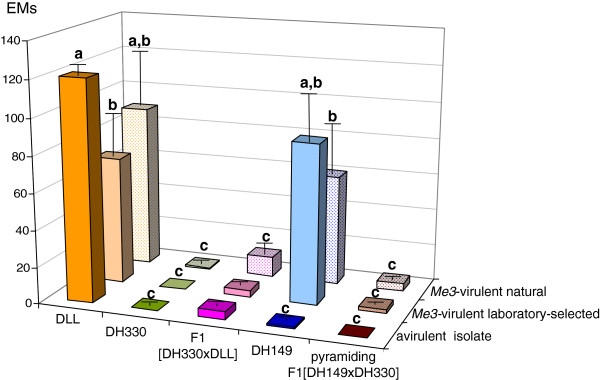
Comparison of mean number of egg-masses (EMs) on peppers maintained in climate controlled room after inoculation with 500 juveniles of avirulent or Me3-virulent laboratory-selected or naturally Me3-virulent M. incognita isolates (mean of 10 to 20 replicates ± standard error). DLL was the susceptible cultivar as control, DH149 is homozygous resistant Me3/Me3, DH330 is homozygous resistant Me1/Me1. Modalities with different letters display significant differences at P = 0.05.